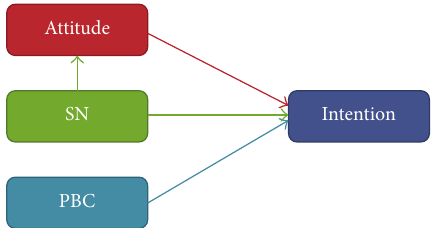
Figure 1: Impact of subjective norm on